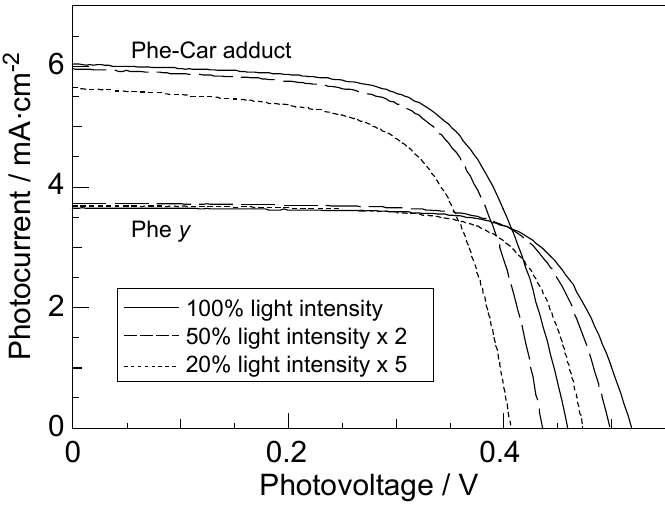
Figure 18. The light-intensity dependence of the I  V curves in solar cells using the Phe y and Phe–Car adduct sensitizers (reprinted from [9] with permission of